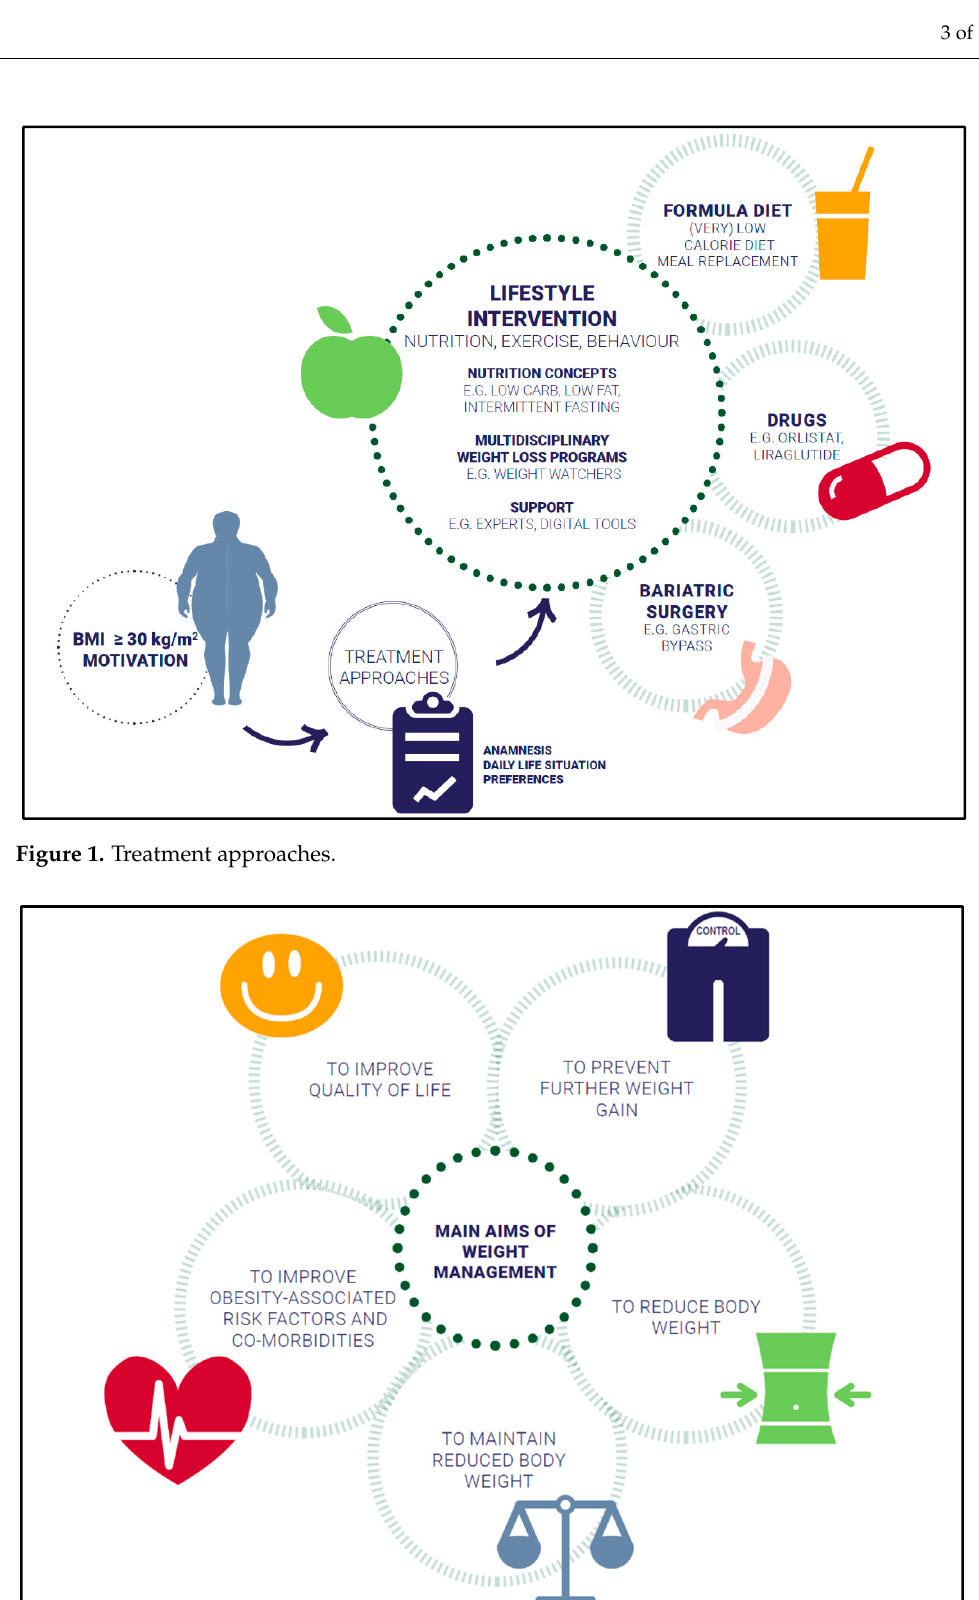
Figure 2. Overview of weight management goals.